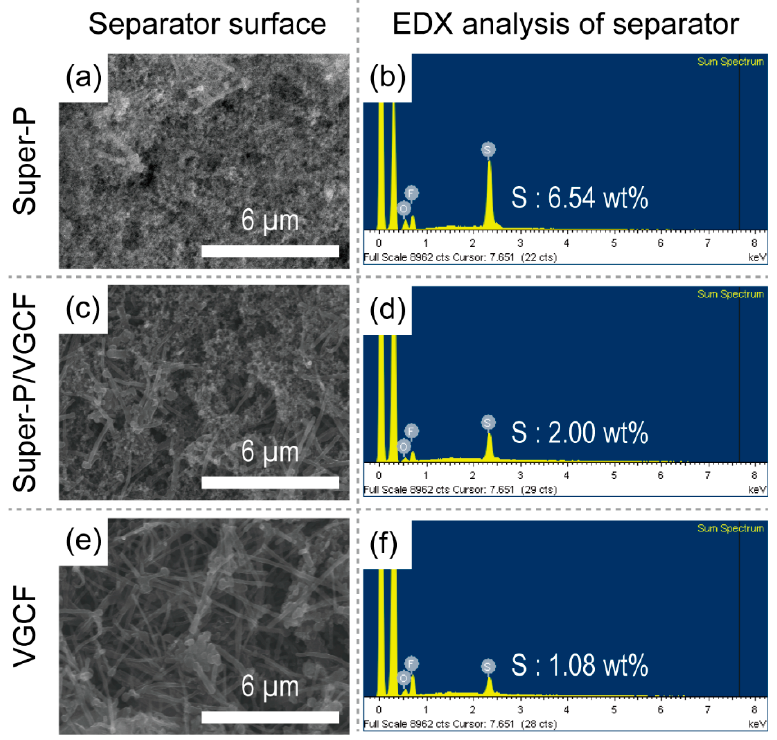
Figure 5. ( a , c , e ) SEM images and ( b , d , f ) EDX elemental analysis of the surfaces of the separators on the cathode side after 20 cycles (corresponding to Figure 3c).